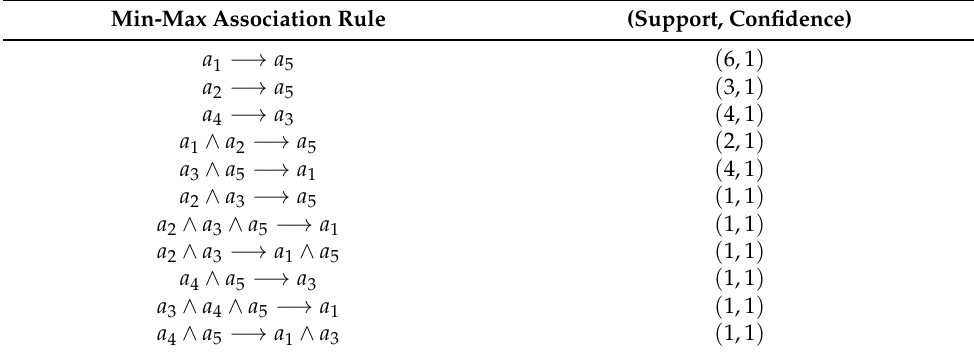
Figure 3. The complete lattice ( T ( R A ) / Table 6. Min-Max association rules with support s and confidence c = 1. Min-Max Association